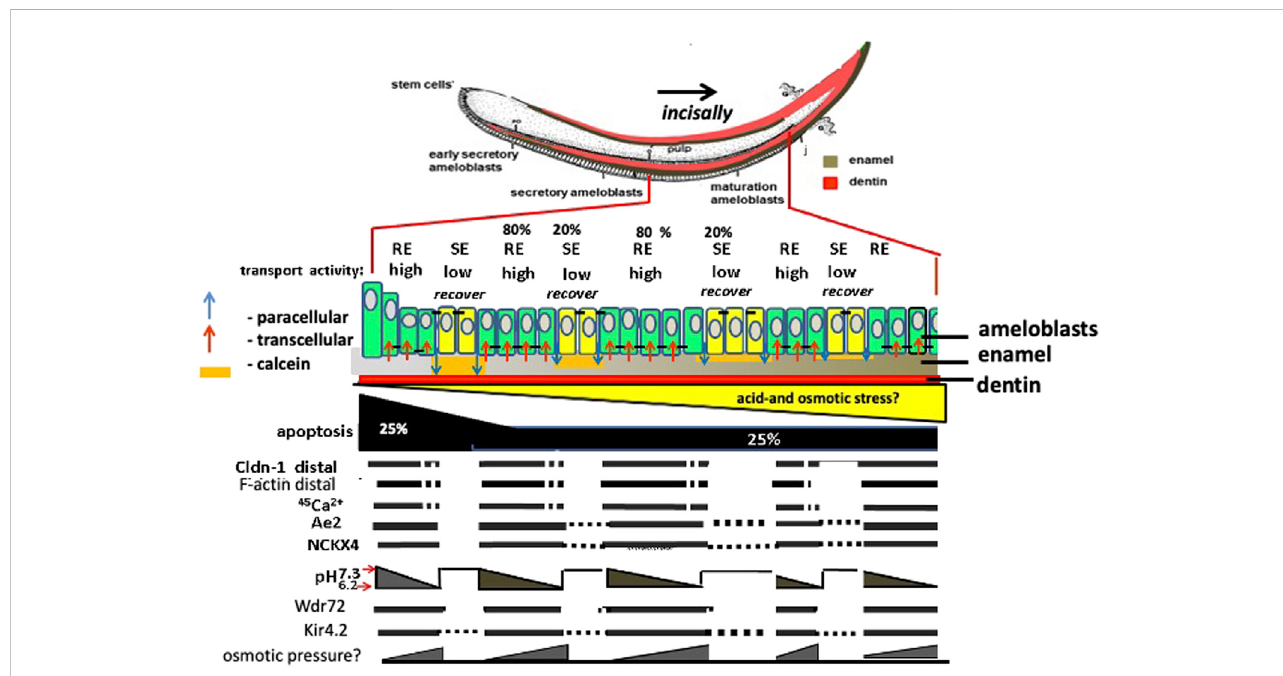
Amelogenesisinmouseincisor:majordifferencesbetweenexpression/activityinREcomparedtoSEameloblasts.Ameloblastsmodulatecorresponding tocalceinstainingofneutralpHenamelmatrixorangecolor.Claudin1(Cldn1)andF-actinareincreasedinRE,associatedTJs,andinRE,Nckx4transportsCa 2+ intotheenamelmatrixforhydroxyapatite(HA)formation.HAformationinenamellowersthepHinenamel fl uid.AsmatrixpHdecreases, Wdr72 increases,and NCKX4 and Kir4.2 translocate to theapical REmembrane.Paracellulartransportofions happens during transformationof REinto SEmodeduring which selective apical tight junctions disappear and basal tight junctions appear forming a new basal barrier. The transition of RE into SE and the fl ushing out of enamel fl uid may result from hyperosmotic pressure of salt building up in the enamel space that causes leakage and eventually loss of the distal TJ by the inward fl ux of fl